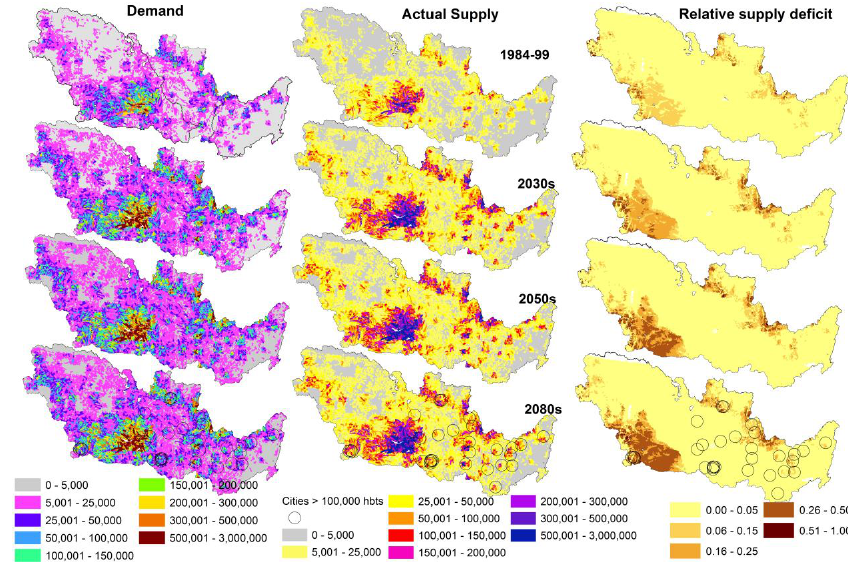
Figure 12: Annual total water demand (left) and actual water supply (center) in cubic meters, and fractional water supply deficit for historical and future B1 periods.